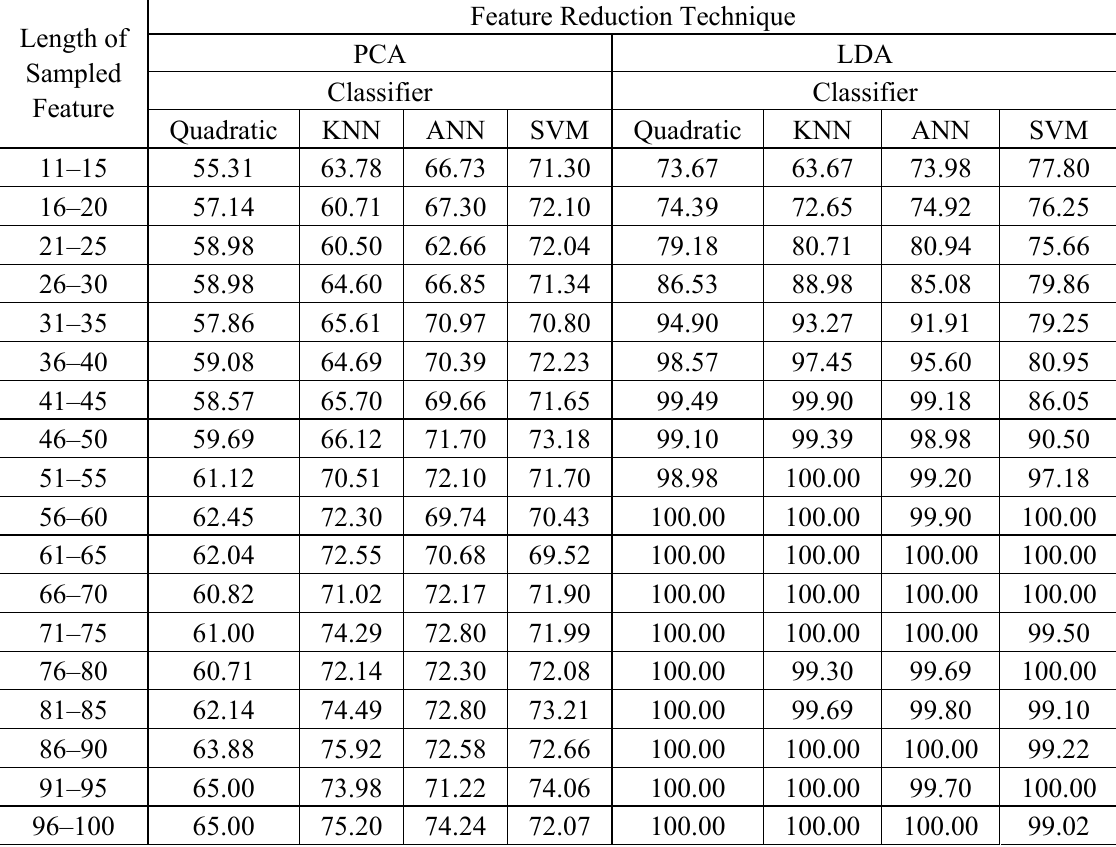
Table 3. Averages of evaluated classification rates for extracted features by gradient method. Length of